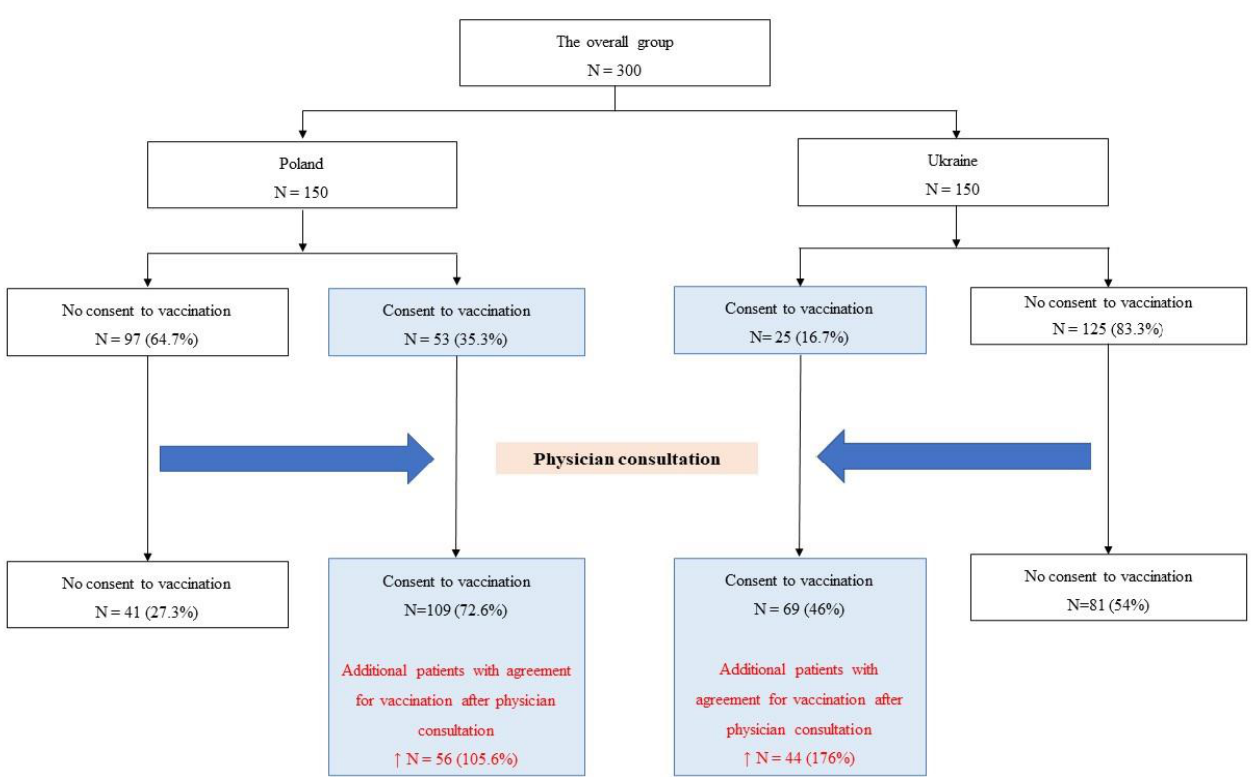
Figure 1. Acceptance of vaccination before and after gynaecologist consultation (Flow chart).